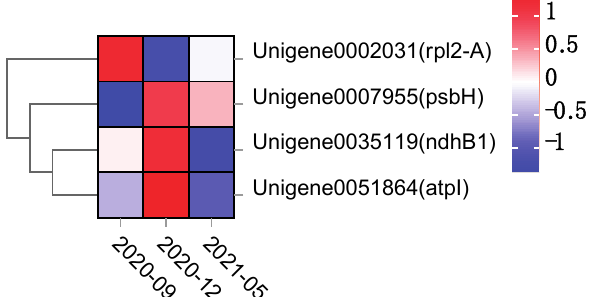
Figure 16. Heatmap of Gene Expression at Different Stages.